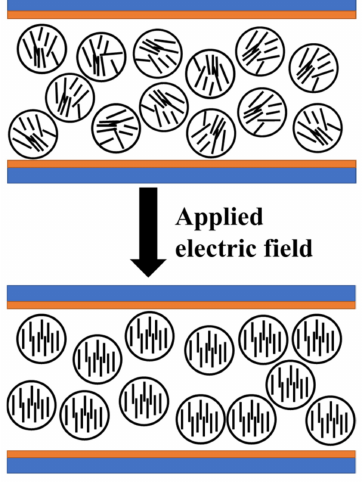
Figure 2. The working principle of PDLC.